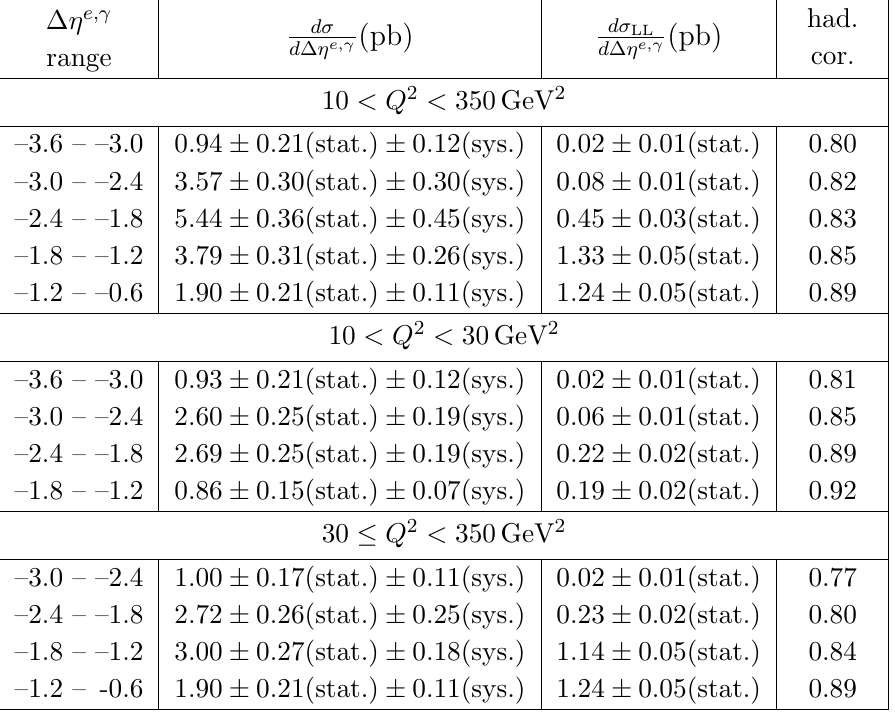
Table 6 . Measured di(cid:11)erential